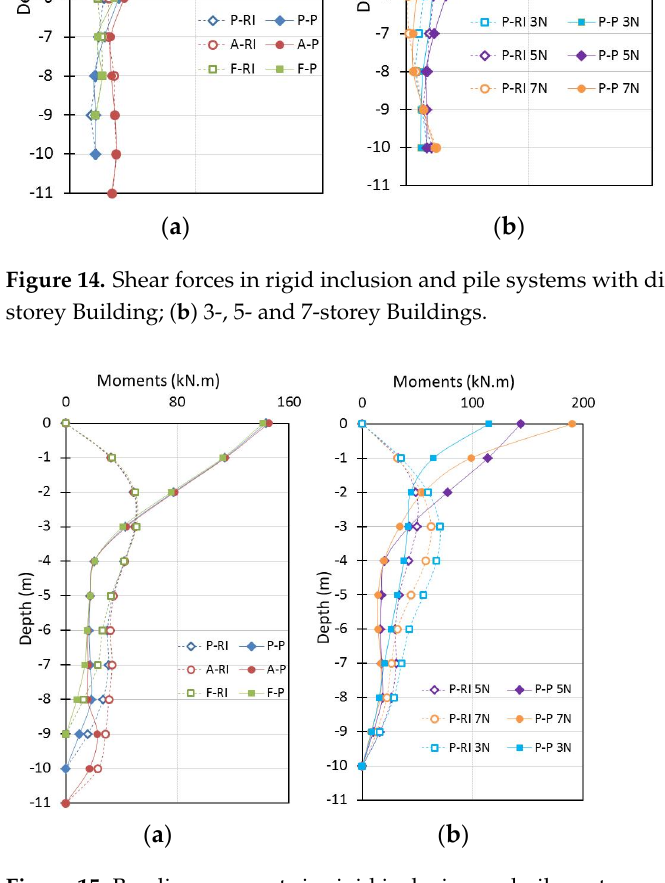
Figure 15. Bending moments in rigid inclusion and pile systems with different support conditions. ( a ) 5-storey Building; ( b ) 3, 5-, and 7-storey Buildings. ( a ) 5-storey Building; ( b ) 3, 5-, and 7-storey